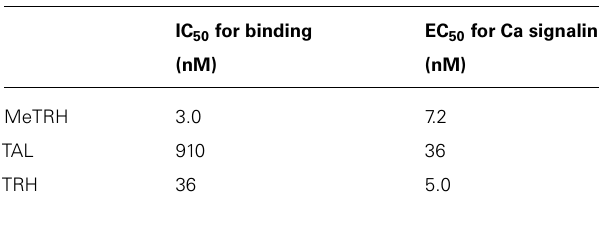
Table 1 | Pharmacological parameters